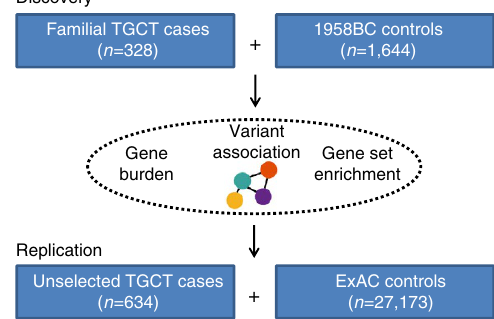
Figure 1 | Study design. Overview of patient samples and exome sequencing study